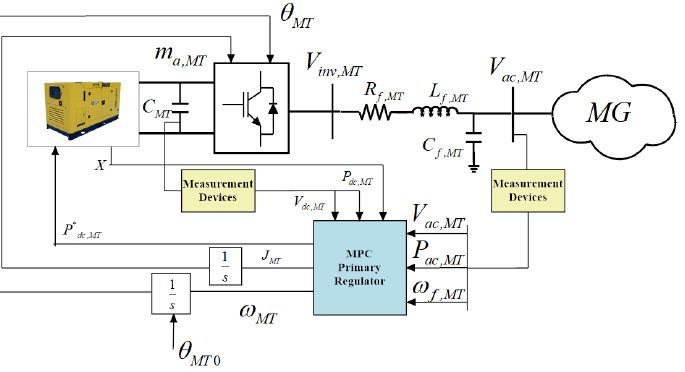
Figure 3. MT Control